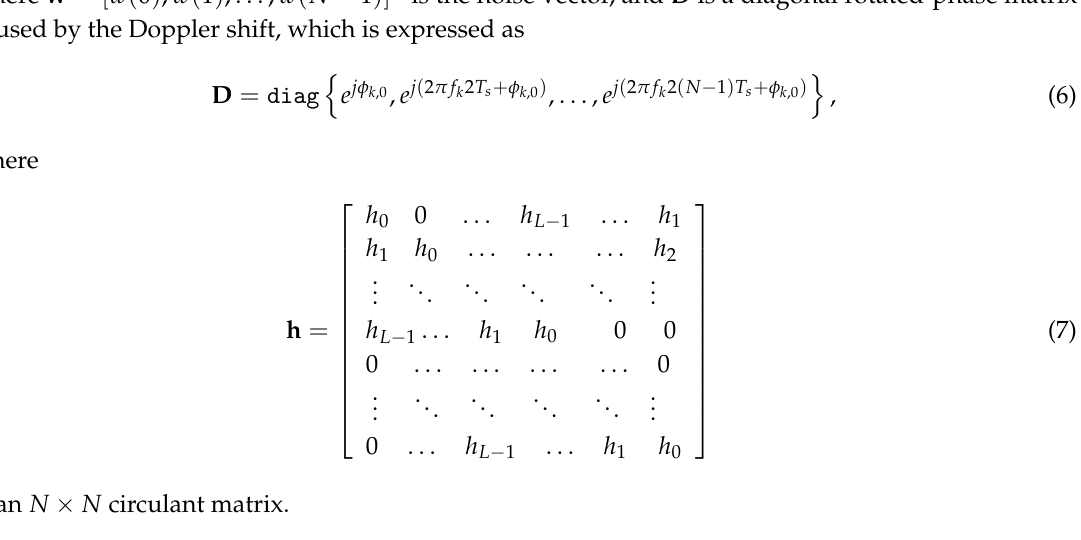
Figure 2 consists of a down-converter, PN remover, FFT, channel estimator, frequency domain equalizer, and inverse Fast Fourier Transform (IFFT). In the receiver, the data is converted to the frequency-domain from time-domain via FFT operation, and then frequency-domain equalization is conducted. The equalized signal is converted back to a time-domain signal. The frequency domain expression of Equation (5) is given